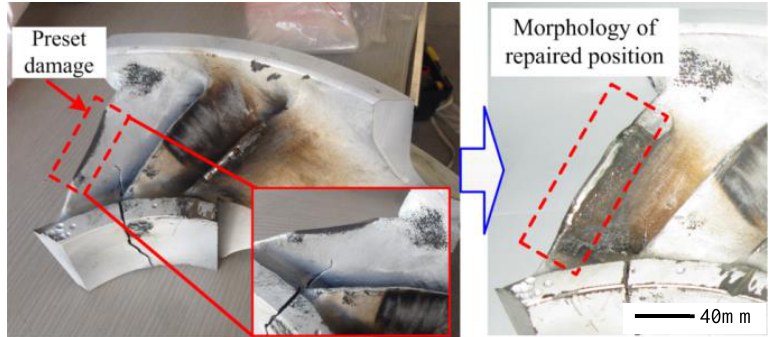
Figure 13. Macro-morphology of one of the repaired position.